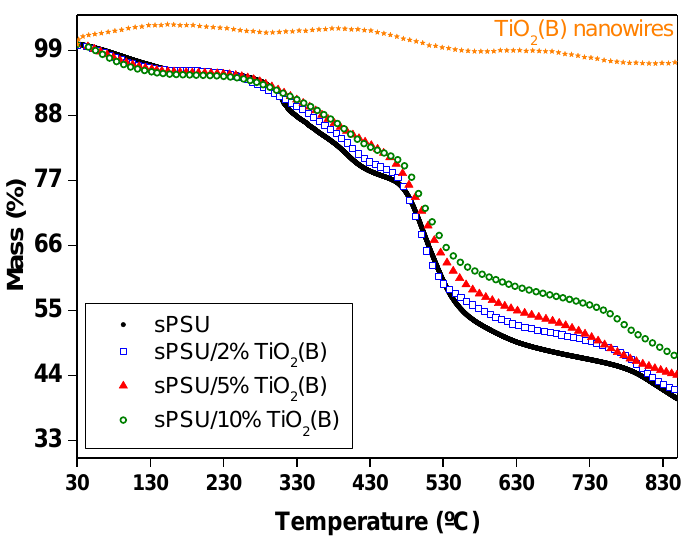
Figure 6. TGA plots of TiO 2 (B) nanowires, sPSU membrane and sPSU/x%TiO 2 (B) composite mem- branes (x = 2; 5 and 10).